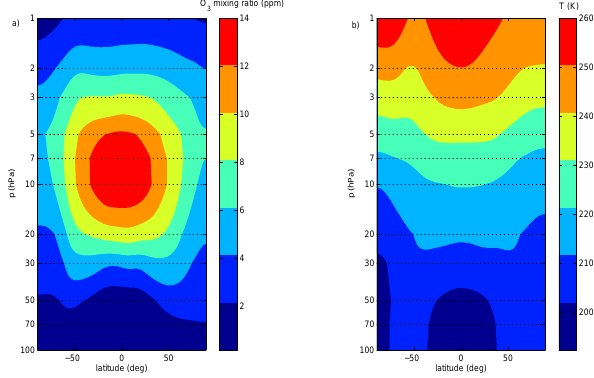
Figure 1. Climatological means for the period 1979–2013 of (a) zonal mean stratospheric O 3 mass mixing ratio and (b) air temper- ature T . Units are ppm for O 3 and K for T